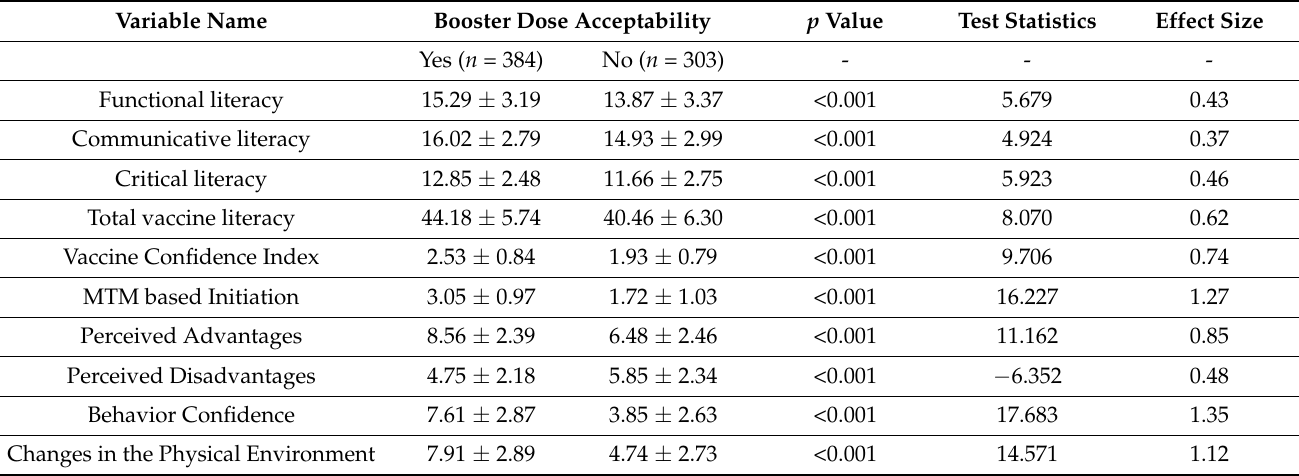
Table 3. Comparing vaccine literacy, vaccine confidence, and MTM based initiation among groups with or without booster dose acceptability ( n = 687).